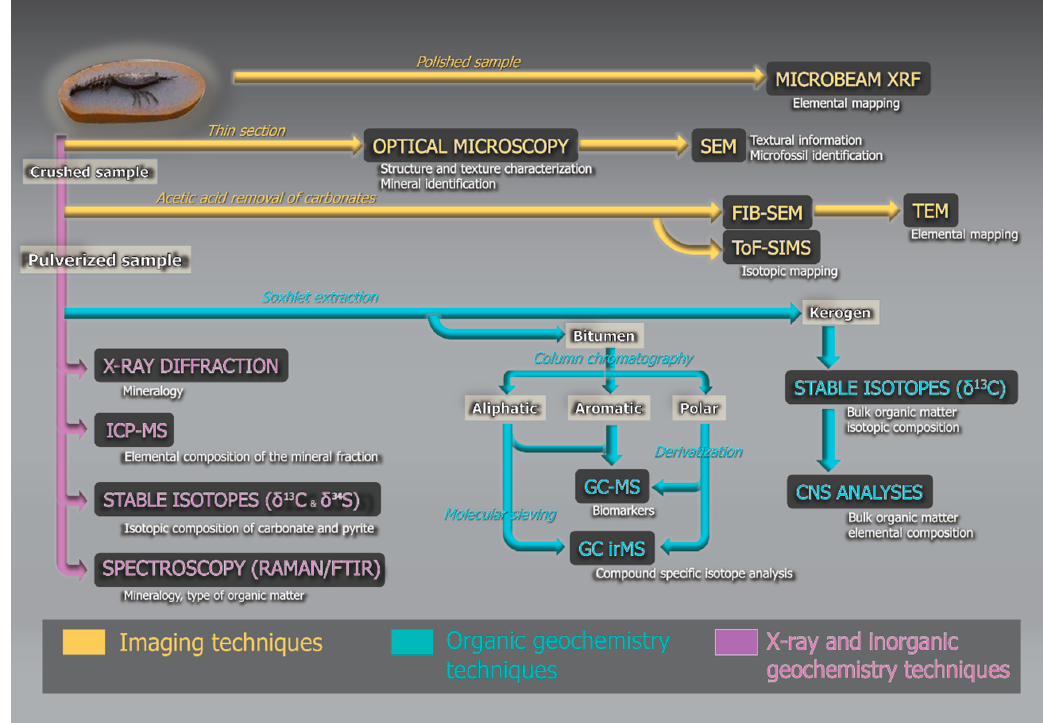
Figure 2. A typical analytical flowchart for the analysis of exceptionally preserved fossils, including nondestructive imaging techniques, and organic and inorganic geochemistry.